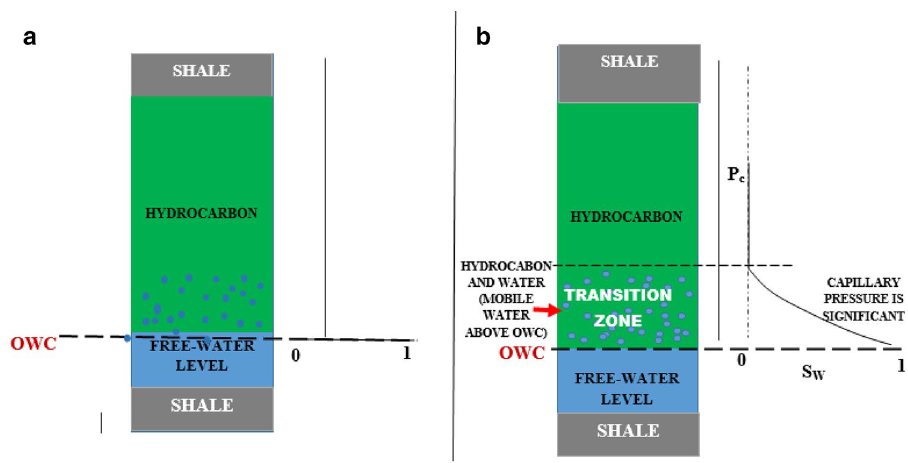
Fig. 1 a Estimate of fluid distri- bution without taking transi- tion zone into consideration. b Transition zone was considered while analysing fluid distribu- tion. OWC is oil–water contact and P c is capillary